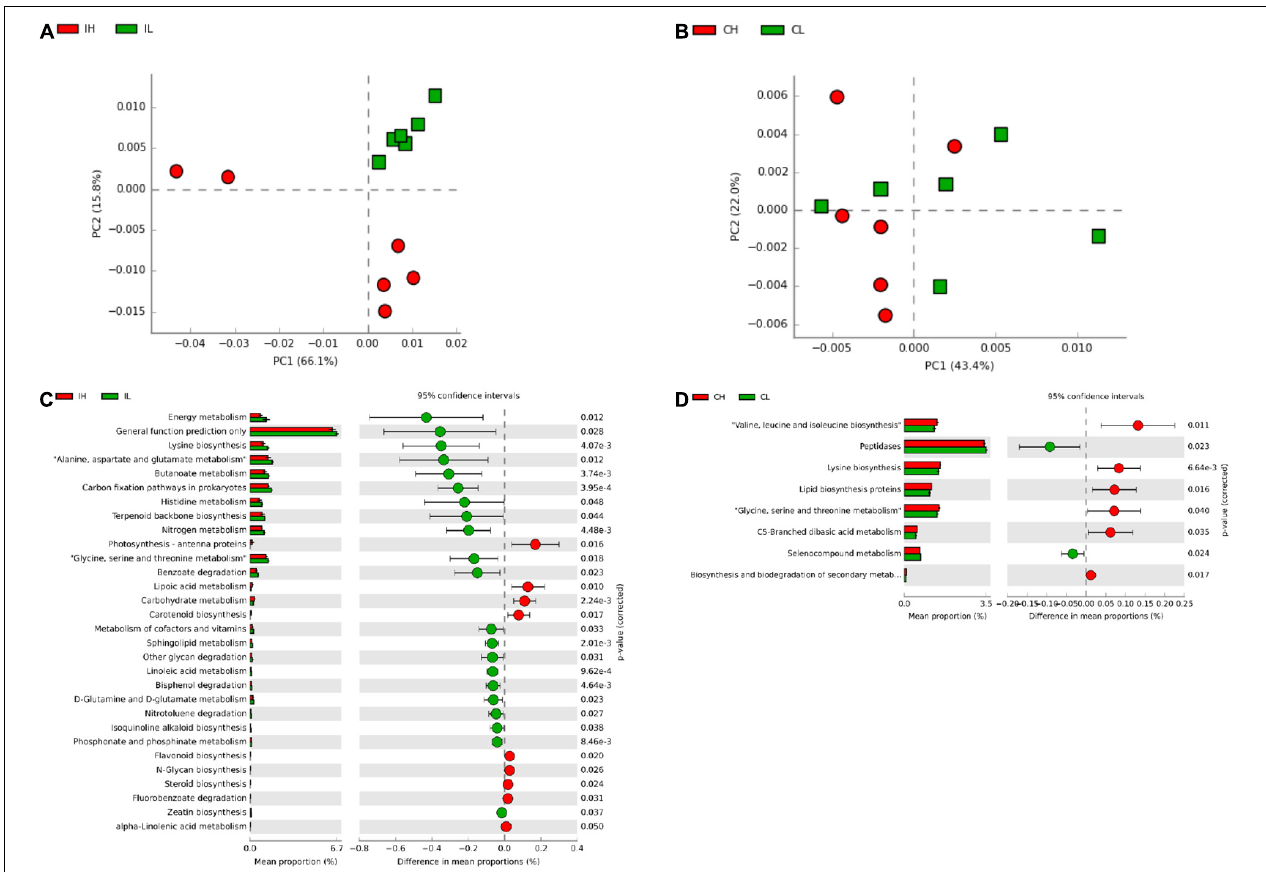
FIGURE 3 | Analysis of functional differences in the ileal and cecal microbiota of piglets between control and Cu-supplemented groups after 6 weeks of feeding. Principal component analysis (PCA) of the functions of the ileal (A) and cecal (B) microbiota, significantly different functions of the ileal (C) and cecal (D) microbiota. IL, ileal microbiota in control group; IH, ileal microbiota in Cu-supplemented group; CL, cecal microbiota in control group; CH, cecal microbiota in Cu-supplemented group. Data were analyzed by Student’s t -test only, due to the minor changes in these microbiome